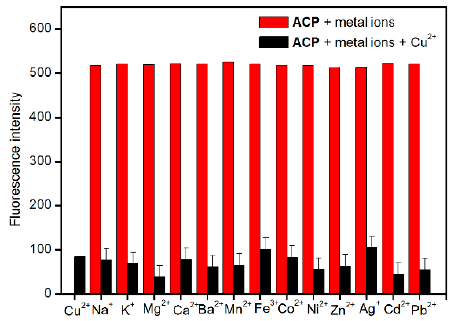
Figure 4. The relative fluorescence intensity diagram of ACP (10 µ M) to different metal ions (1 equiv.). Excitation was at 412 nm, and emission was at 668 nm.